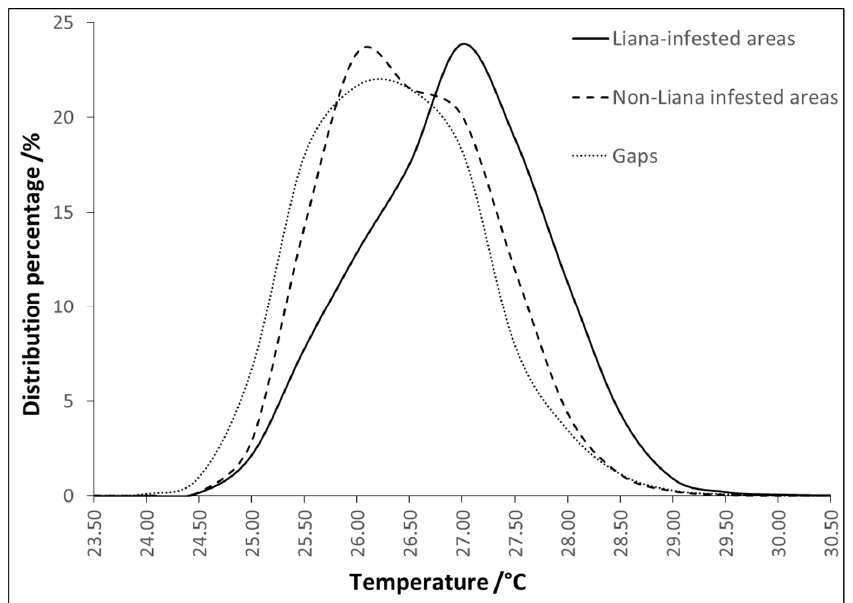
Figure 4. Temperature distribution percentages shown for liana-infested areas, non-liana infested areas, and gaps.